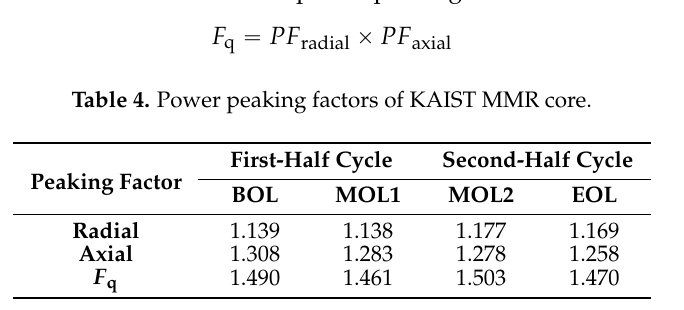
Table 5. Worth the reactivity control system of the MMR core.